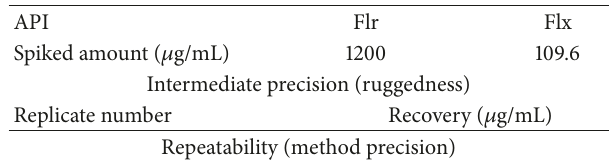
Table 5: Evaluation of the accuracy of the method developed in this study.